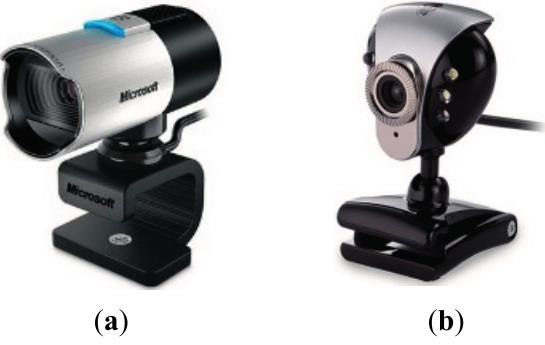
Figure 1. ( a ) Microsoft LifeCam Studio 1080P Full-HD and ( b ) E-books W6 PC Webcam.